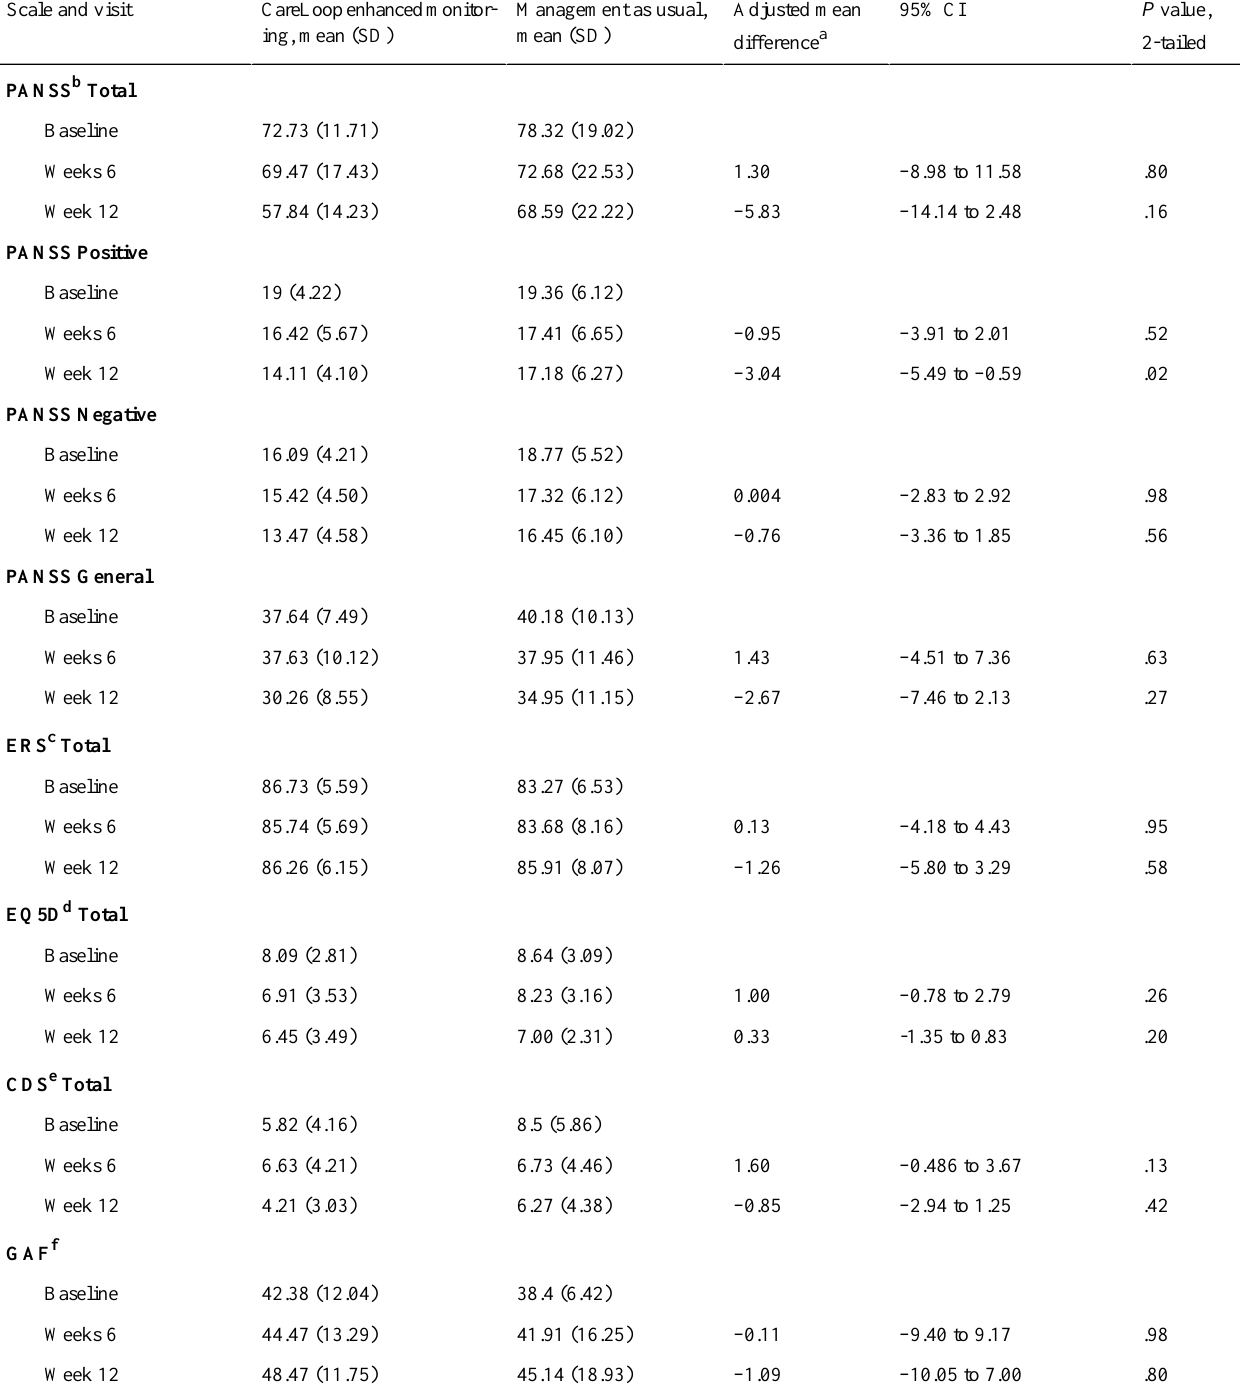
Table 4. Clinical measures at baseline, 6 weeks, and 12 weeks: community team sample.